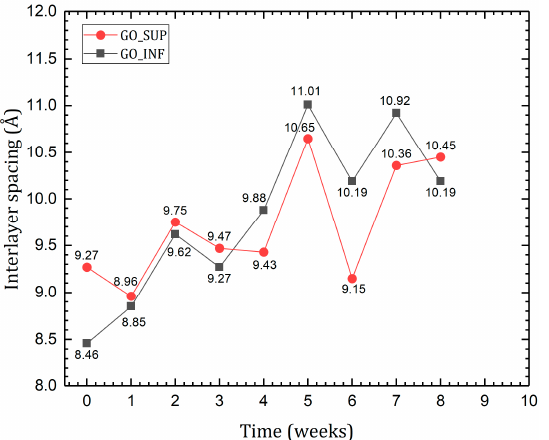
Figure 9. Calculated interlayer distance variation of the GO sheets over the course of eight weeks after the synthesis.